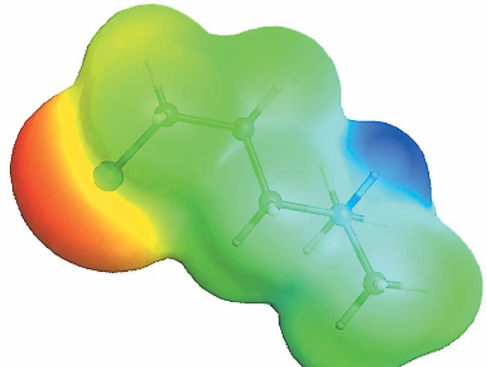
Figure 2 Electrostatic potential plot of the molecular cation in the title compound from the reported DFT calculation. Red represents the most negatively charged regions and blue the most positively charged regions.